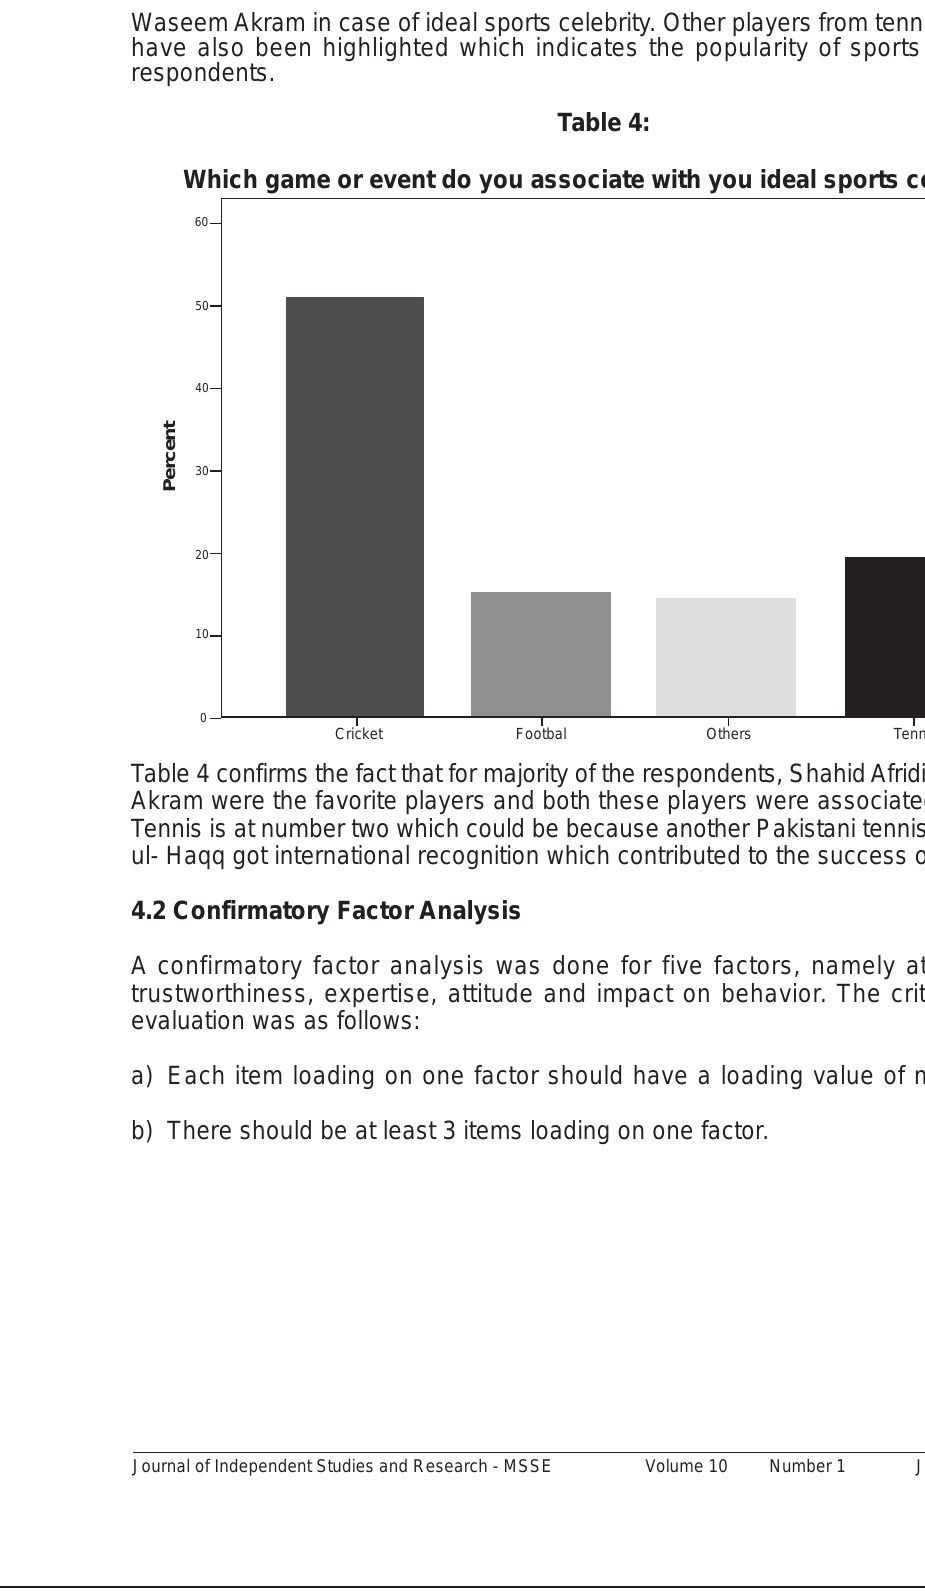
Which game or event do you associate with you ideal sports